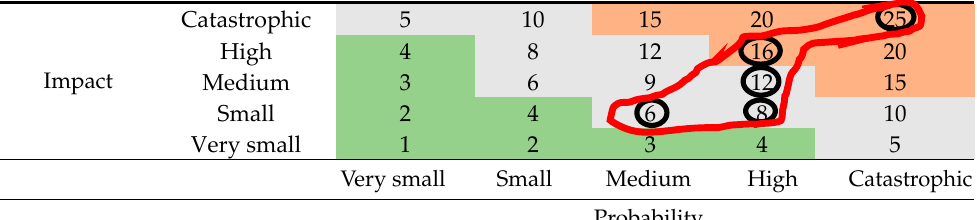
Table 6. Risk map with marked fields of the estimated risk of supply chains.